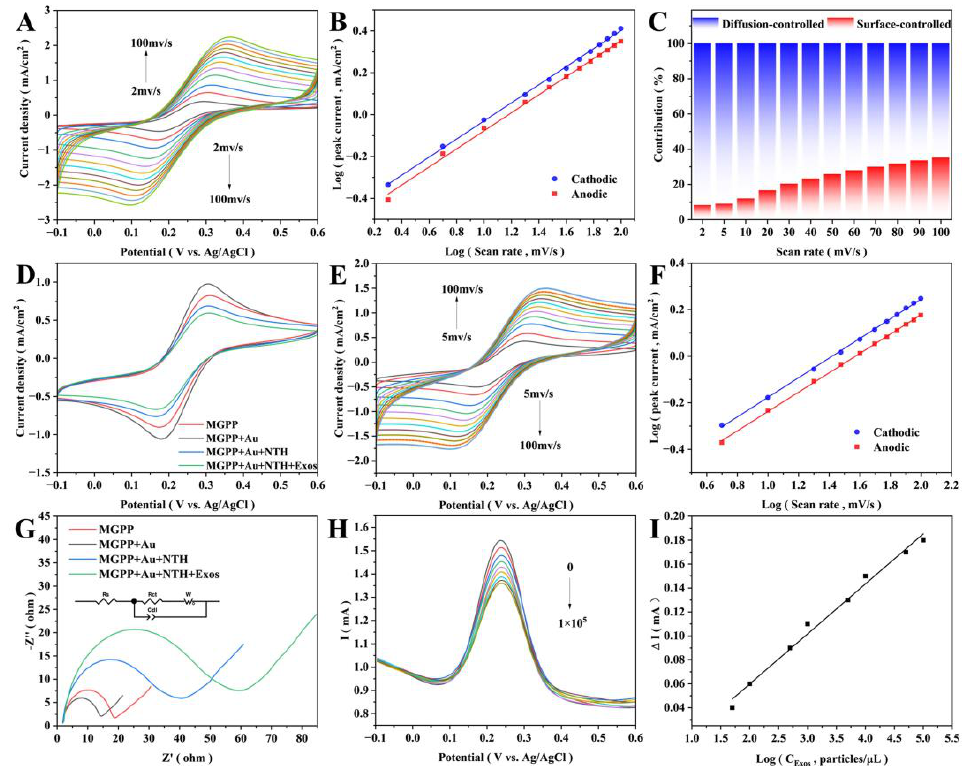
Figure 5. Construction of electrochemical biosensor and quantitative detection of exosomes. Self- supported electrode’s ( A ) CV curves at different sweep speeds (from top to bottom: 2, 5, 10, 20, 30, 40, 50, 60, 70, 80, 90, 100 mV/s), ( B ) relationship between the sweep speed log and peak current log, and ( C ) contribution of surface control and diffusion control to the current at different sweep speeds. ( D ) CV of the electrochemical biosensor assembly process. Assembled sensor’s ( E ) CV curves at different sweep speeds (from top to bottom: 5, 10, 20, 30, 40, 50, 60, 70, 80, 90, 100 mV/s) and ( F ) relationship between the sweep speed log and the peak current log. ( G ) EIS of the sensor assembly process, inset shows the fitted equivalent circuit diagram. ( H ) DPV of the sensor detecting different concentrations of exosomes (from top to bottom: 0, 50, 10 2 , 5 × 10 2 , 10 3 , 5 × 10 3 , 10 4 , 5 × 10 4 , 10 5 particles/μL). ( I ) Relationship between the exosome concentration’s log and the peak currents’ diff erence.